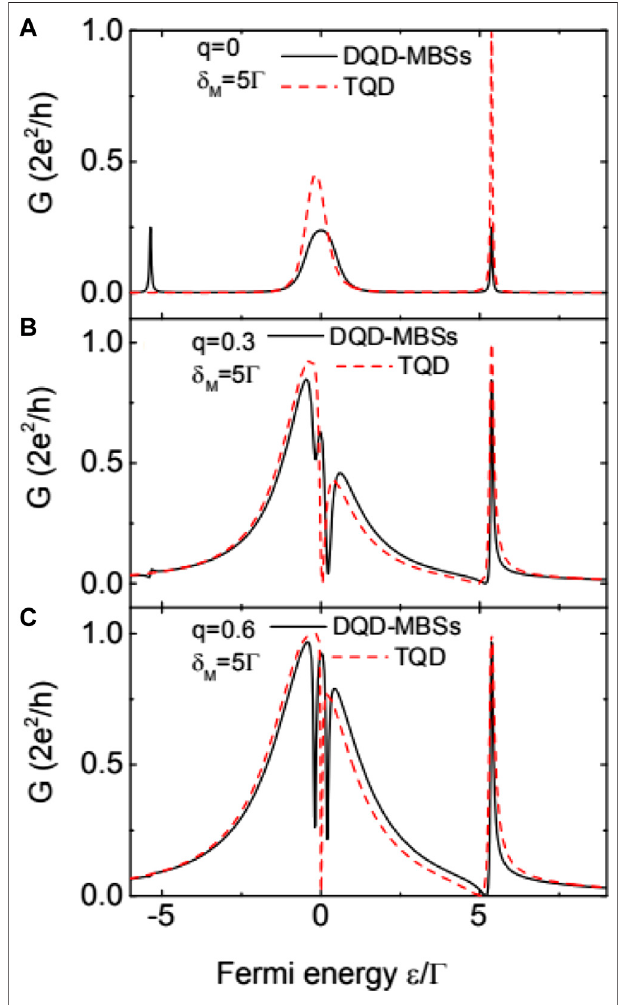
FIGURE 5 | Linear conductance as a function of the Fermi energy for DQD-MBSs and TQD con fi gurations for q (cid:1) 0 in (A) , q (cid:1) 0.3 in (B) , q (cid:1) 0.6 in (C) . Except the parameters given in the fi gure, others are as in Figure 4